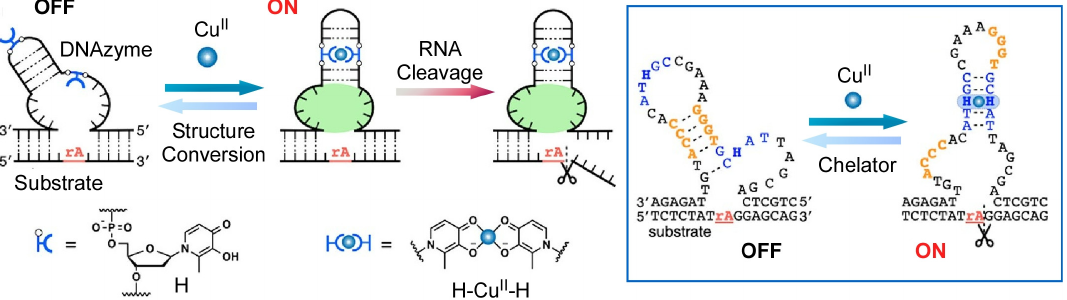
Figure 8. The control of DNA enzymes incorporating artificial hydroxypyridone ligand-type nucle- otides (H) that form CuII-mediated base pairs. Reprinted with permission from Reference [135]. Copyright 2020 American Chemical Society.